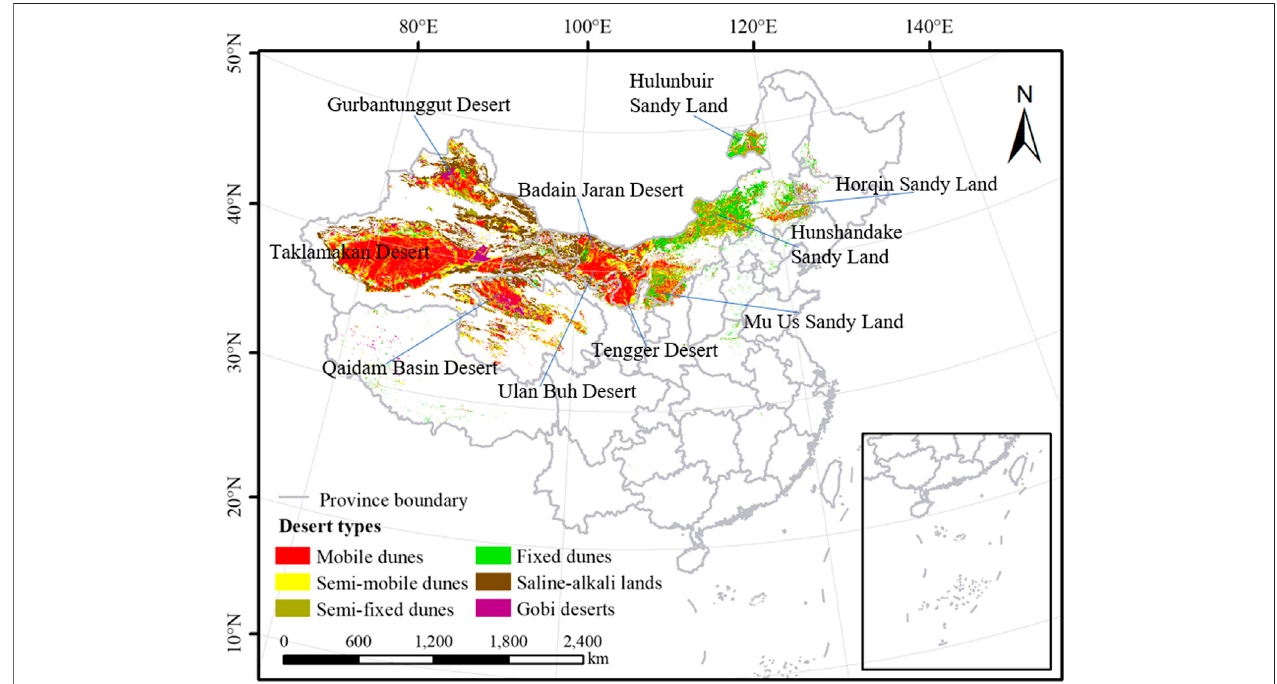
FIGURE1| Locationofthestudyarea,andthespatialdistributionofthedeserttypesin2000basedona1:100,000scaledesert-distributionmapofChinacreated from Landsat TM images. The desert types are de fi ned in Table 1 . Source: Environmental & Ecological Science Data Center for West China, National Natural Science Foundation of China